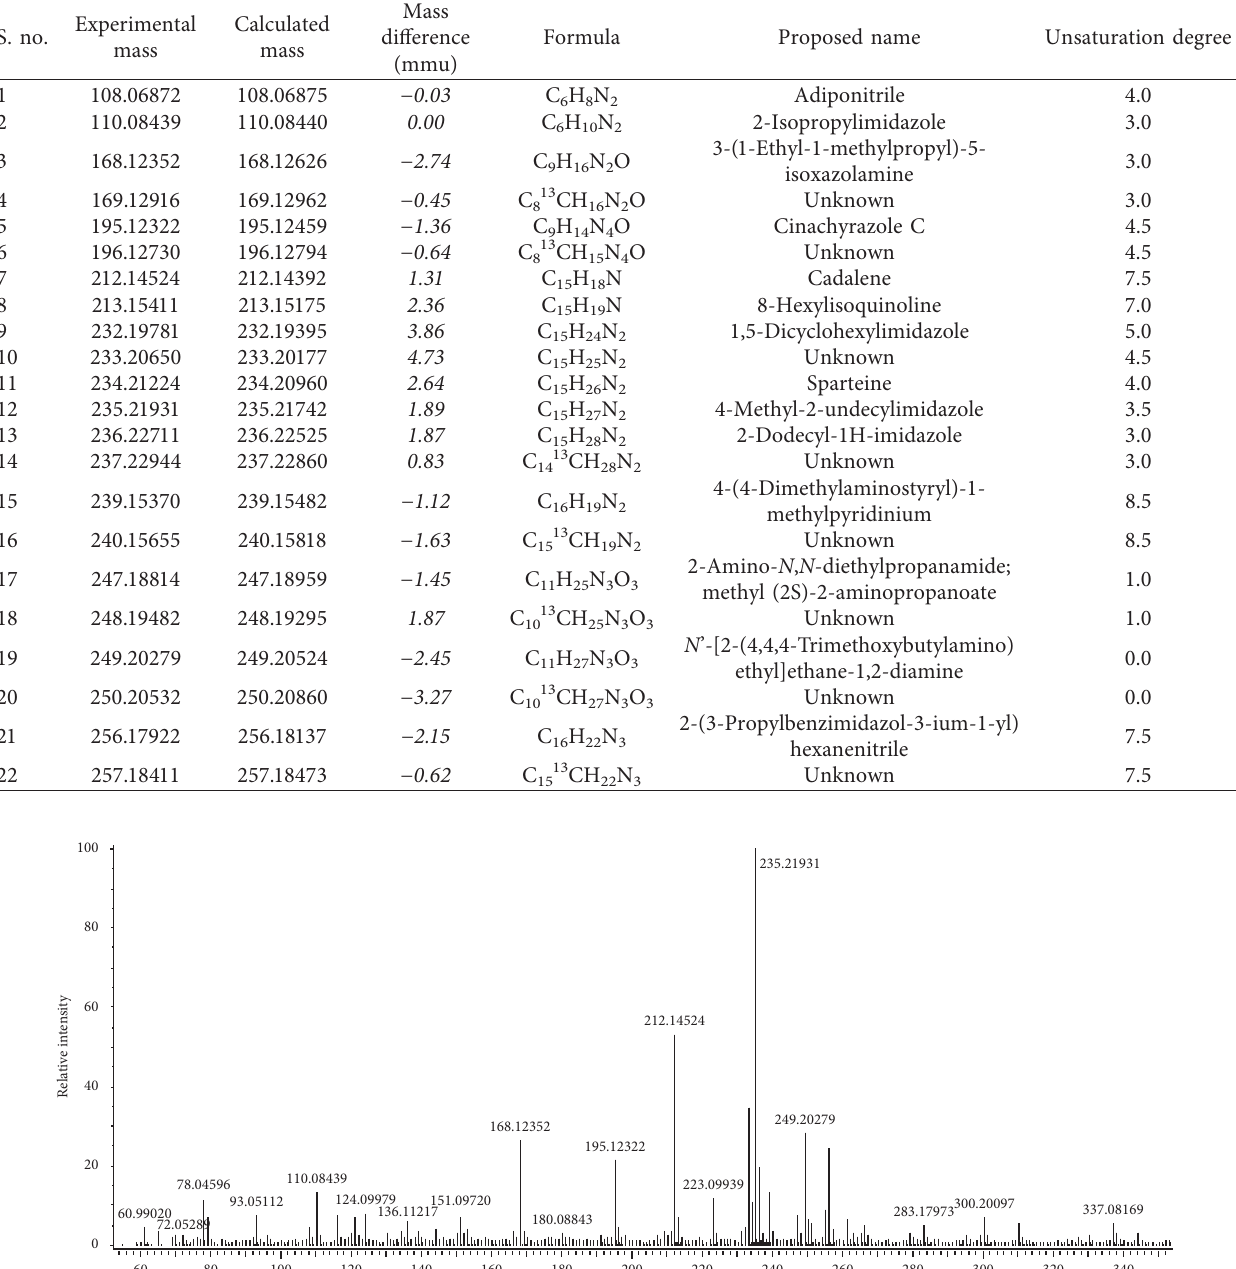
Table 2: The main constituents characterized in R. raetam plant stem by DART-MS. S. no.